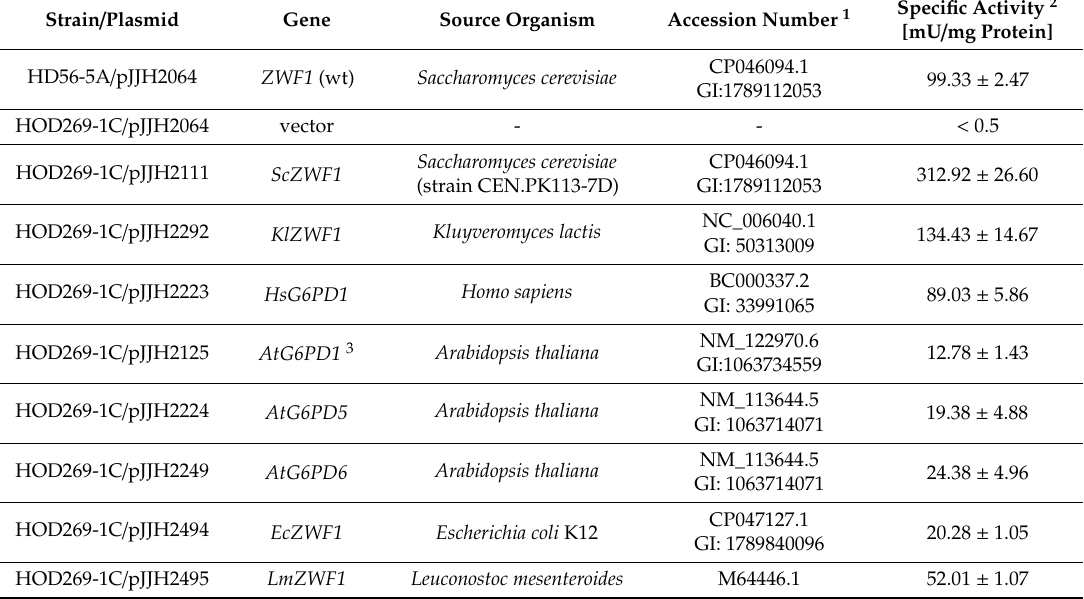
Table 2. Genes expressed in a yeast zwf1 deletion and specific G6PD